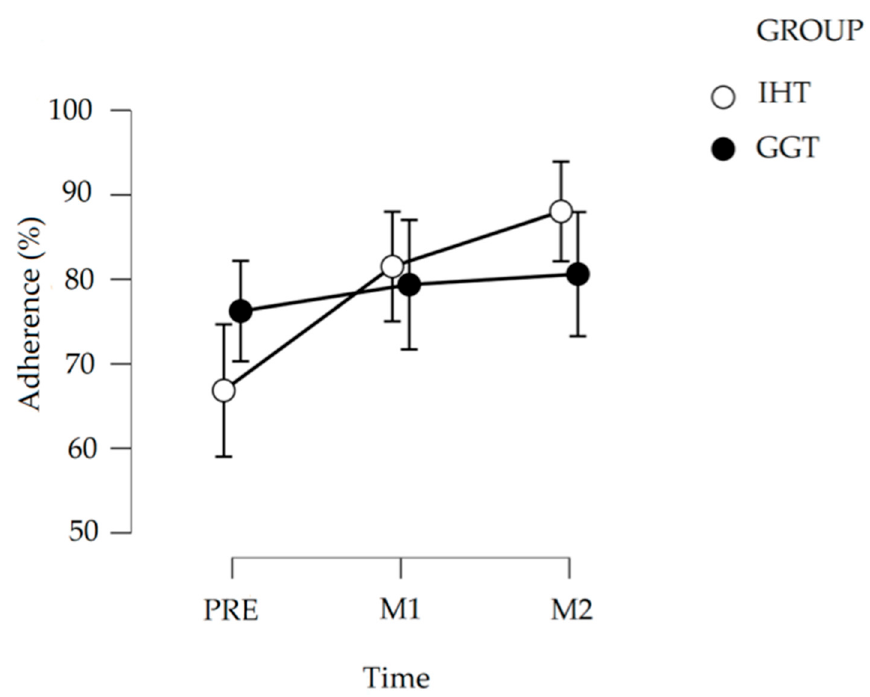
Figure 1. Average percentage of adherence in a three-month period: before (PRE) and one (M1) and two (M2) months after the beginning of lockdown (8 March 2020). The error bars represent the SD. Table 2. Repeated measure ANOVA.